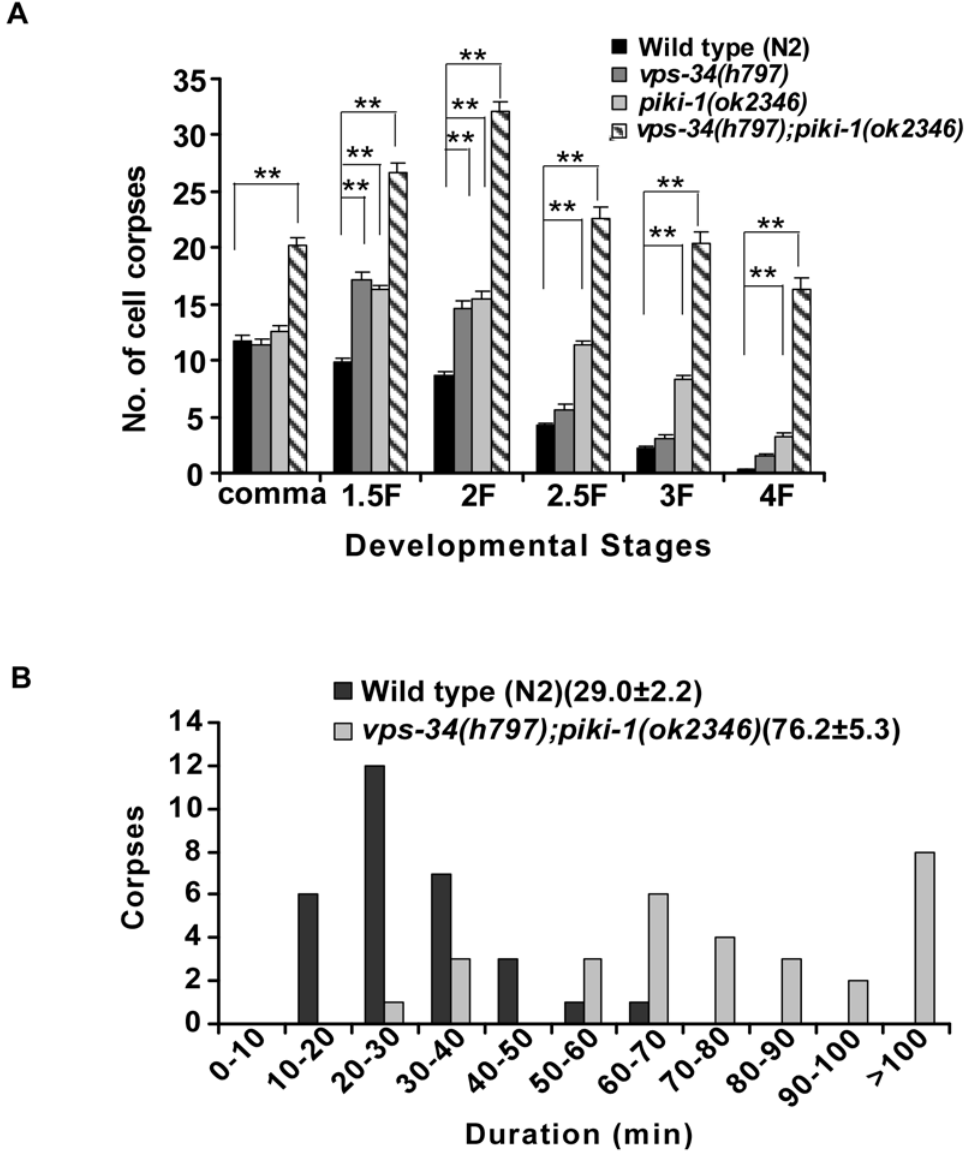
Figure 5. PI3Ks VPS-34 and PIKI-1 are important for cell corpse clearance. (A) PI3Ks VPS-34 and PIKI-1 act redundantly to remove apoptotic cells. Time-course analysis was performed in wild type (black), vps-34 (h797) (gray), piki-1(ok2346) (light gray), and vps-34(h797);piki-1(ok2346) double mutants (hatching). Cell corpses were scored and analyzed as described in Figure 1. Data from wild type and mutant animals were compared as described in Figure 1. ** P , 0.0001; all other points had P value . 0.05. (B) Four-dimensional microscopy analysis of cell corpse duration in vps- 34(h797);piki-1(ok2346) mutants. The durations of 30 cell corpses from wild type (n=3; black bars) and 34 cell corpses from vps-34(h797);piki-1(ok2346) double mutants (n=3; gray bars) were monitored as described in Figure 2 and Materials and Methods. The numbers in parenthesis indicate the average duration of cell corpses ( 6 s.e.m).